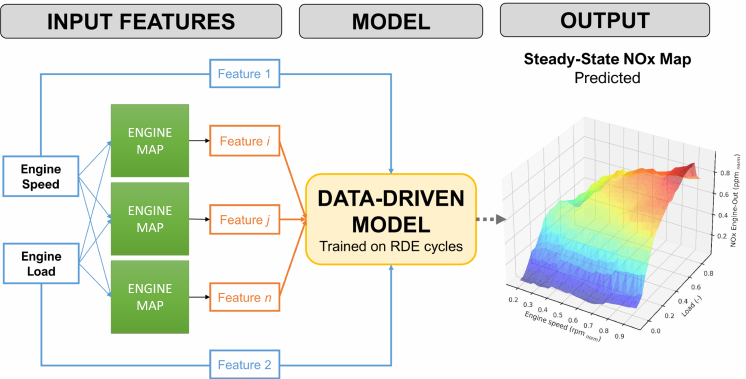
Figure 15. Steady-state NOx map prediction. Engine speed and load (blue) are the only independent features, whereas the other features are obtained from base maps. Thereby, the final prediction of the model can be represented as a 3-D map depending only on the engine speed and load.